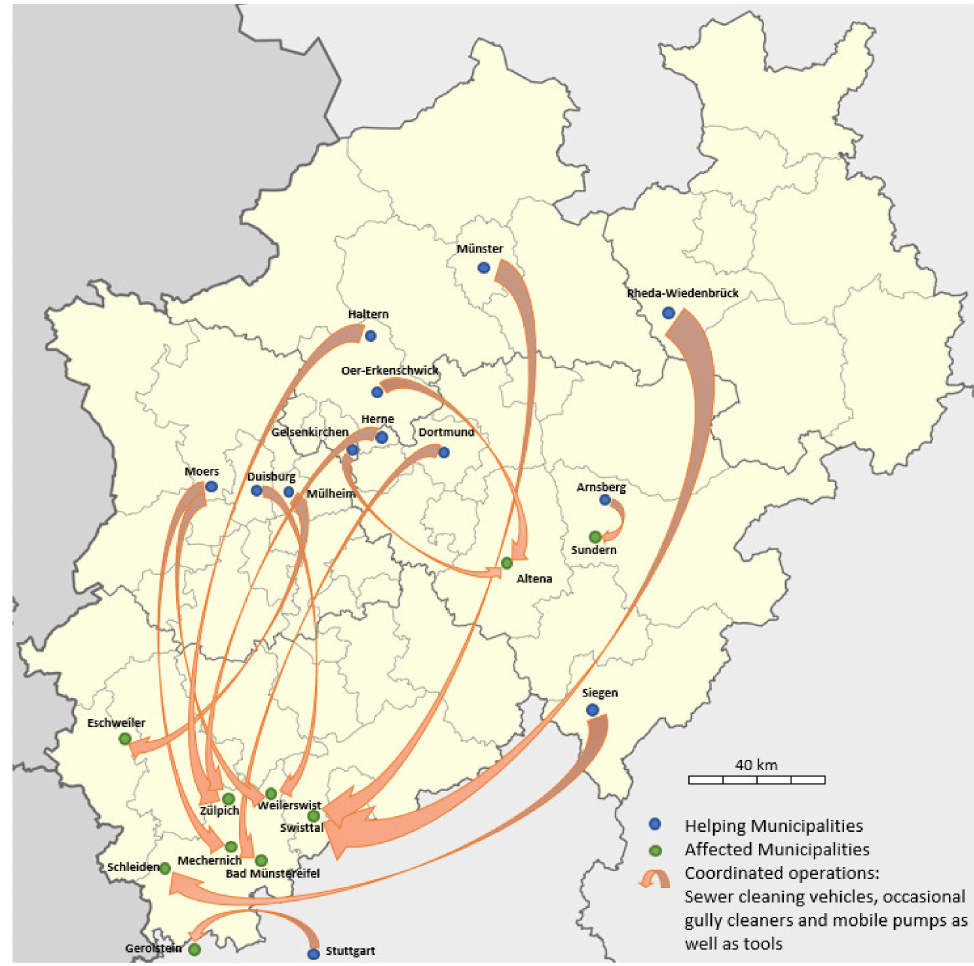
Figure 3. Emergency operations/deployments (first